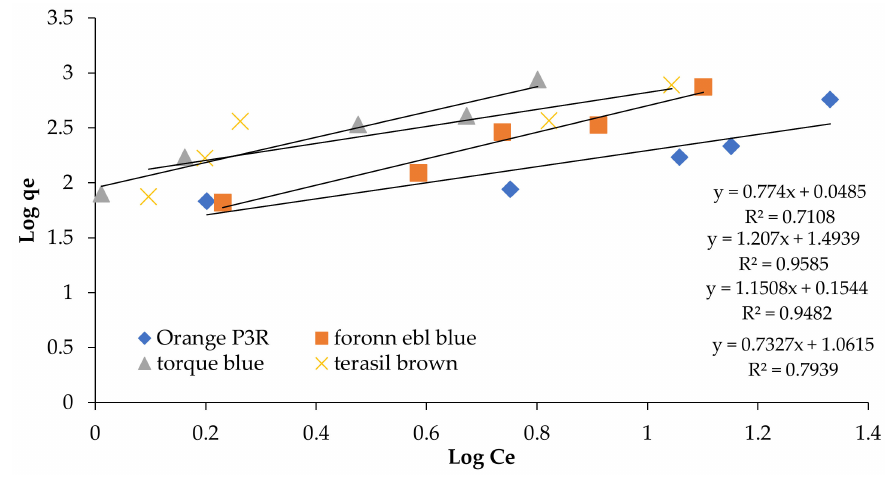
Figure 6. Fruendlich Isotherm at 5 concentrations for non-calcinized composite.